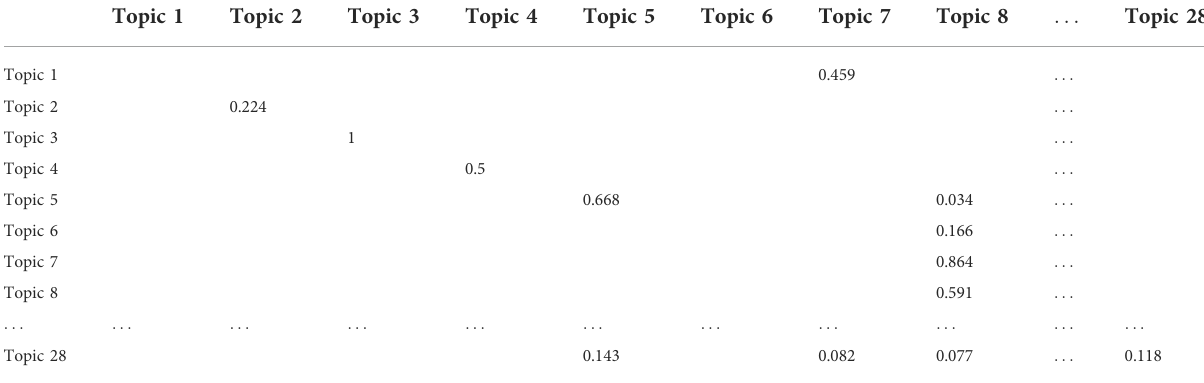
TABLE 7 Matrix of optimal confusion relations between